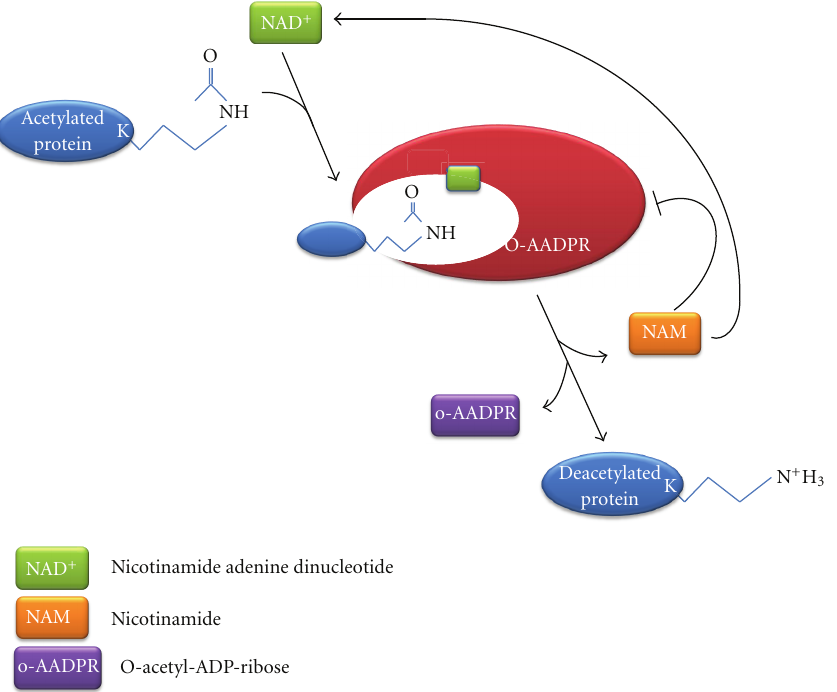
Figure 1: Protein deacetylation by Sirtuins. Sirtuins deacetylate lysine (K) residues of target proteins using cofactor—Nicotinamide-adenine- dinucleotide (NAD + ) and releasing Nicotinamide (NAM). 2 (cid:2) -O-acetyl-ADP ribose is generated as a result of transfer of the acetyl group of K onto ADP-ribose residue. Deacetylation is inhibited by NAM, which can also reverse the reaction to reproduce NAD +